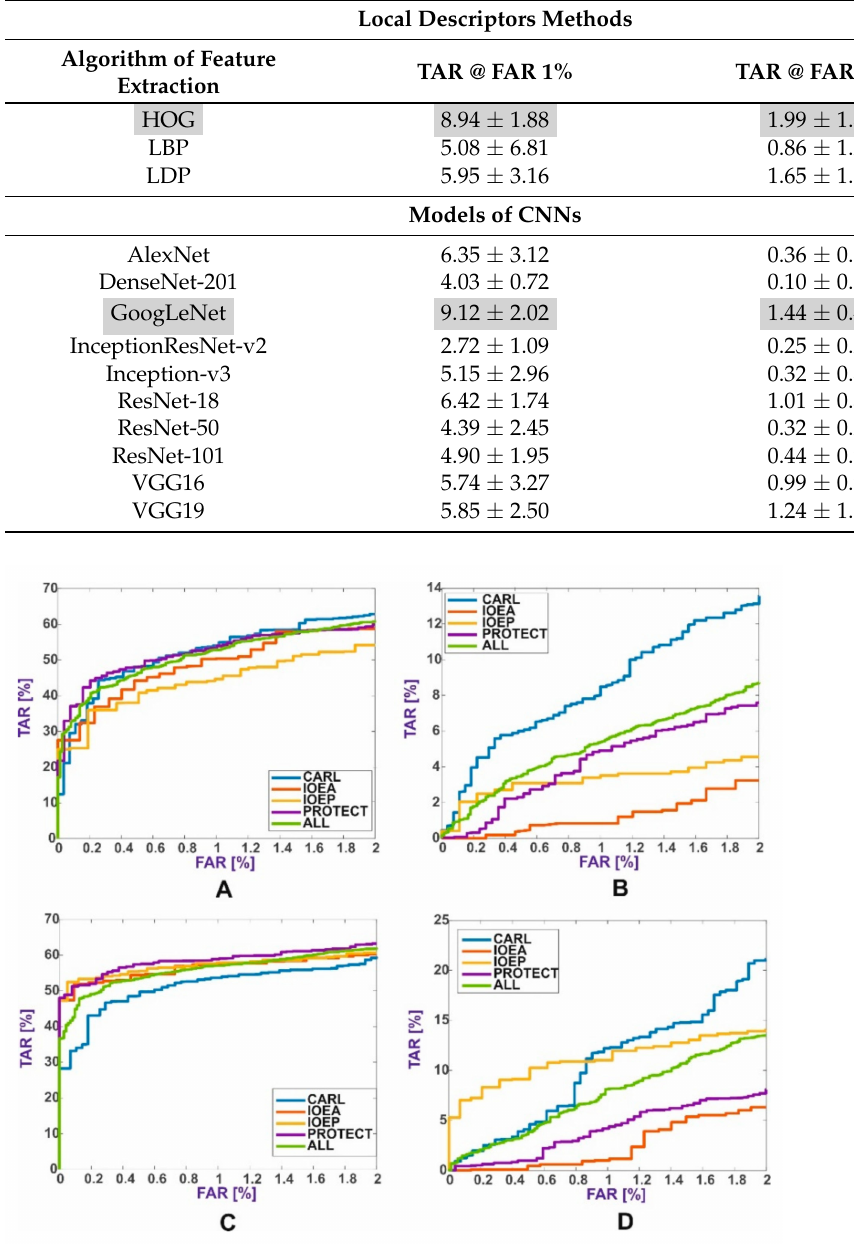
Table 4. TAR results for the local descriptor and CNN models with SVM.